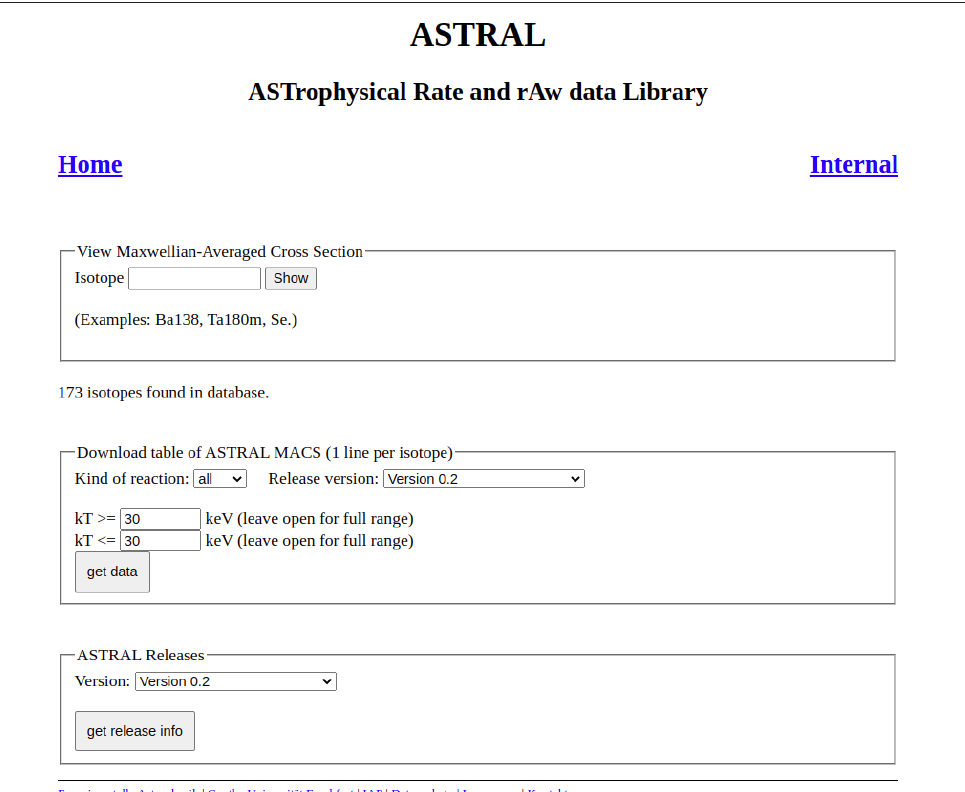
Figure 1. Web appearance of the ASTRAL database